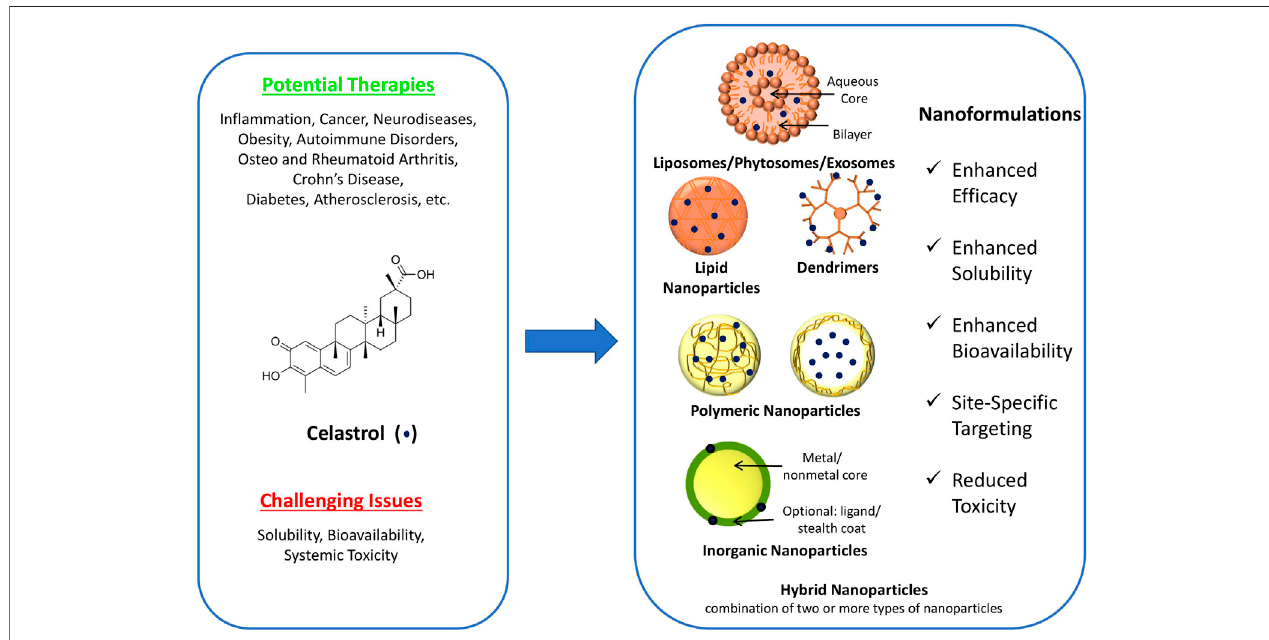
FIGURE1| Structure ofcelastrol, potential therapies,challenging issues,and schematicrepresentation ofvarious celastrolnanoformulations[modi fi edfrom Desai et al. (2012)].